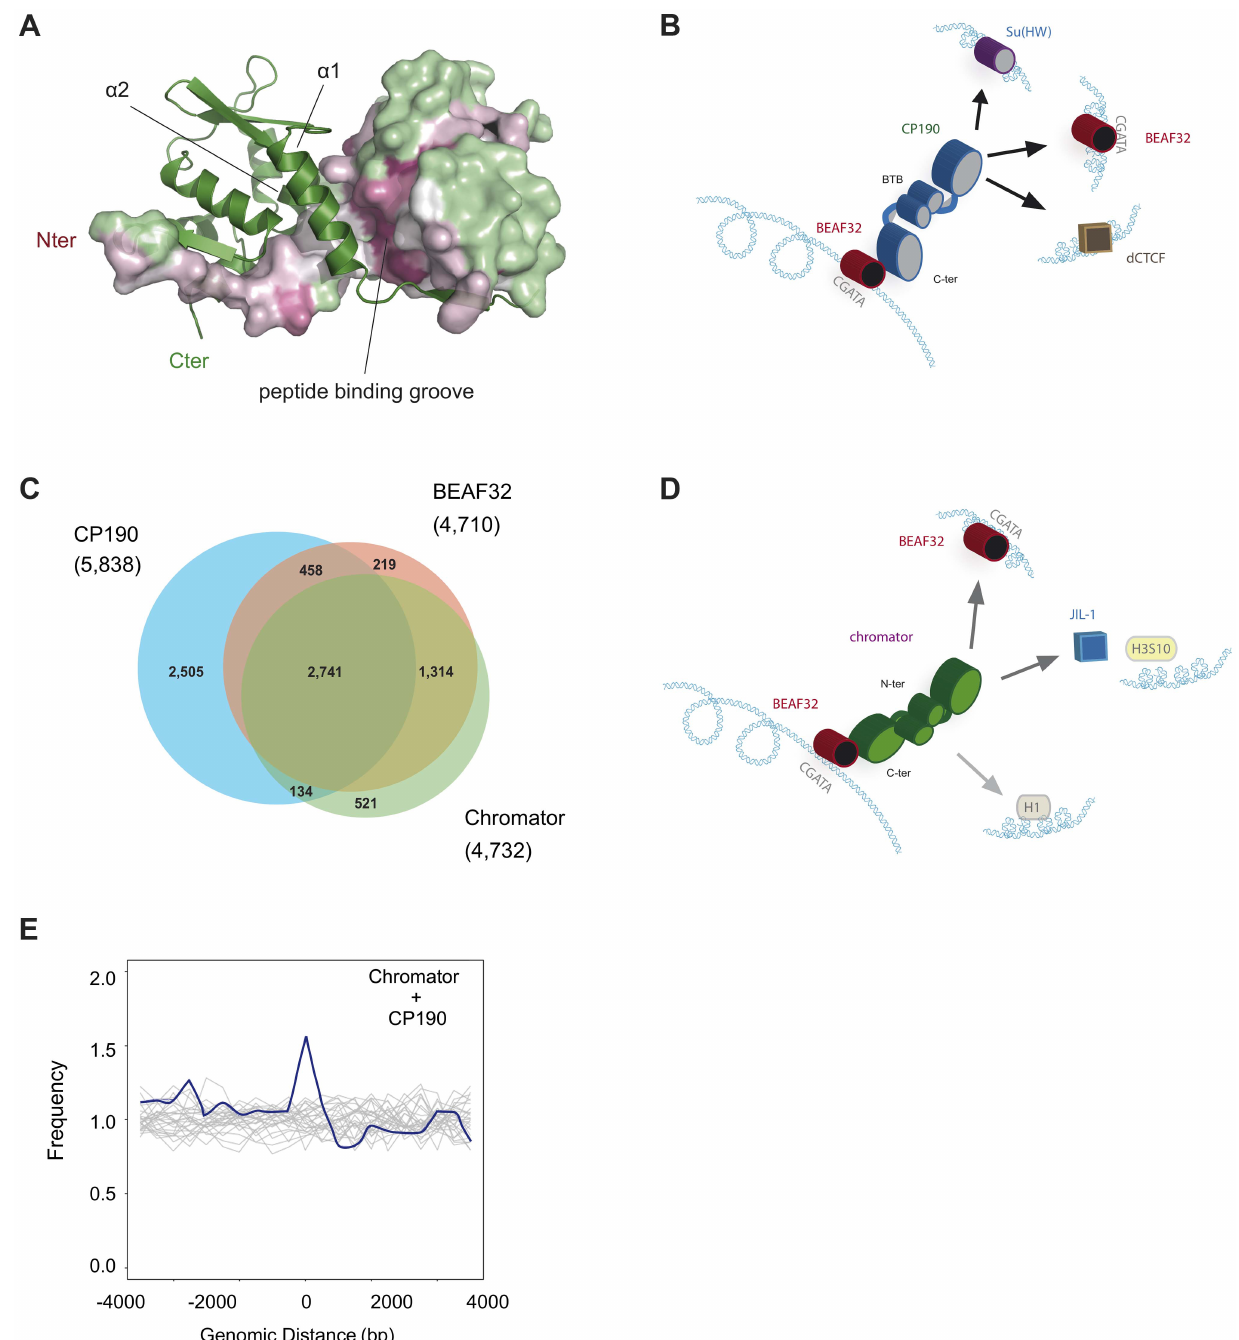
Figure 6. Structure of CP190-BTB/POZ, genome-wide localization of insulator factors at long-range contacts, and models. (A) CP190- BTB/POZ crystallizes as a homo-dimer. The secondary structure of one monomer is shown in green and the surface of the second monomer is color- coded by conservation (pink: high, green: low). Monomers are mainly held together by interactions between helices a 1 and a 2. The peptide binding groove and the N-terminal domains are highly conserved and may participate in protein-protein interactions (discussed in text). (B) Schematic model for the formation of long-range interactions by CP190. The BTB/POZ domains of CP190 (blue) interact to form a dimer. Contacts between the C- terminal domain of CP190 and BEAF32 (red) or other insulator binding proteins (Su(HW), blue, dCTCF, brown) can lead to the formation of hybrid long-range contacts. (C) Venn diagram showing the genome-wide overlap between BEAF32, CP190 and Chromator in S2 cells calculated from publicly available modENCODE ChIP-chip data. (D) Schematic model highlighting the possible roles of Chromator/BEAF32 interactions. Chromator (green) could act as a LRI-forming protein bridging BEAF32 (red) binding sites, as well as serve to recruit the JIL-1 kinase (blue box) to regions of active chromatin. (E) Aggregation analysis was performed on Hi-C data to identify proximity correlations and functional relationships between anchors (BEAF32 binding sites) and signals (CP190/Chromator binding sites). Aggregation profiles are built by aligning and aggregating the Hi-C signals of CP190/Chromator peaks at a certain genomic distance d (15 , d , 60 kbp) from BEAF32 binding sites. BEAF32 is used as the anchor and CP190/Chromator signals are aligned (at d =0) and summed together. The y-axis shows the number of interactions every 500 bp normalized by the